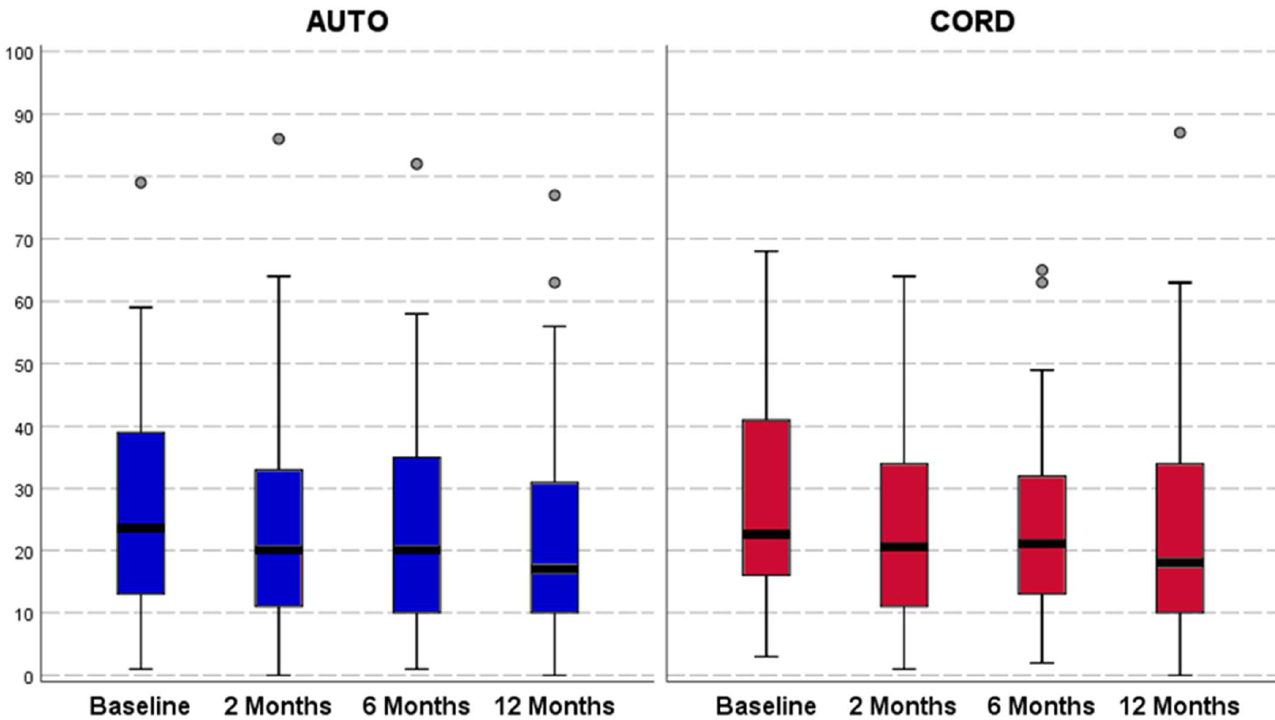
Figure 4. Western Ontario and McMaster Universities Osteoarthritis Index (WOMAC; 0–100 points) trends in both treatment groups. The horizontal black line represents the median, the box limit represents quartiles, and error bars represent 95% Confident Intervals. Table 2. Clinical scores at baseline and follow-ups.